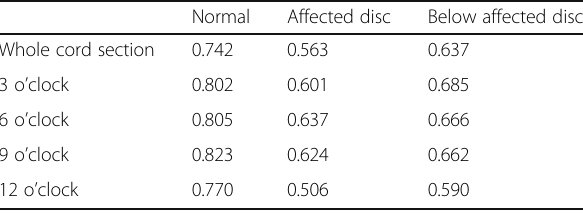
Table 2 Comparison between mean FA values classified in the normal blue code of the normally oriented according to normal cord, cord opposite to most affected disc craniocaudal cervical cord fibers. and cord below the most affected disc levels at different sites (cid:1) Multiple ROIs were manually drawn within the Normal Affected disc Below affected disc cervical cord in the axial combined anatomical and color-coded FA images opposite to all cervical discs levels. (cid:1) The drawn ROIs included only the cervical cord and we tried to exclude any surrounding CSF. (cid:1) FA values of all ROIs opposite to cervical discs were